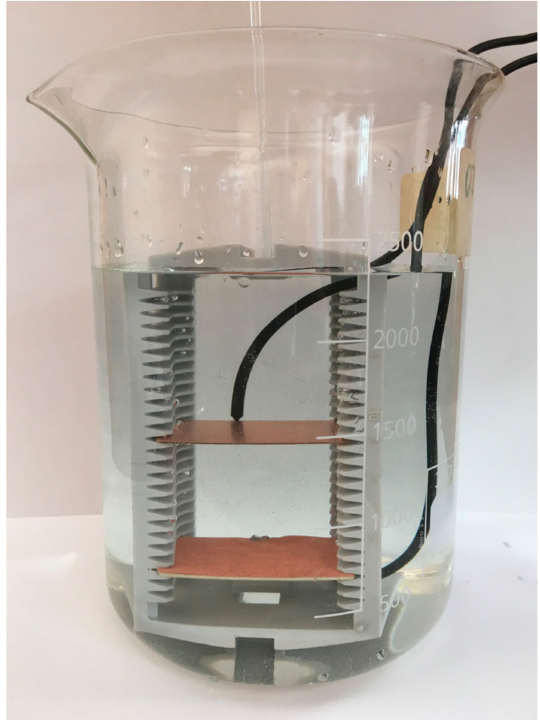
Figure 6. Immersed plastic holder with electrodes inside the electrolyte to give a measurement of the resistance between two electrodes.